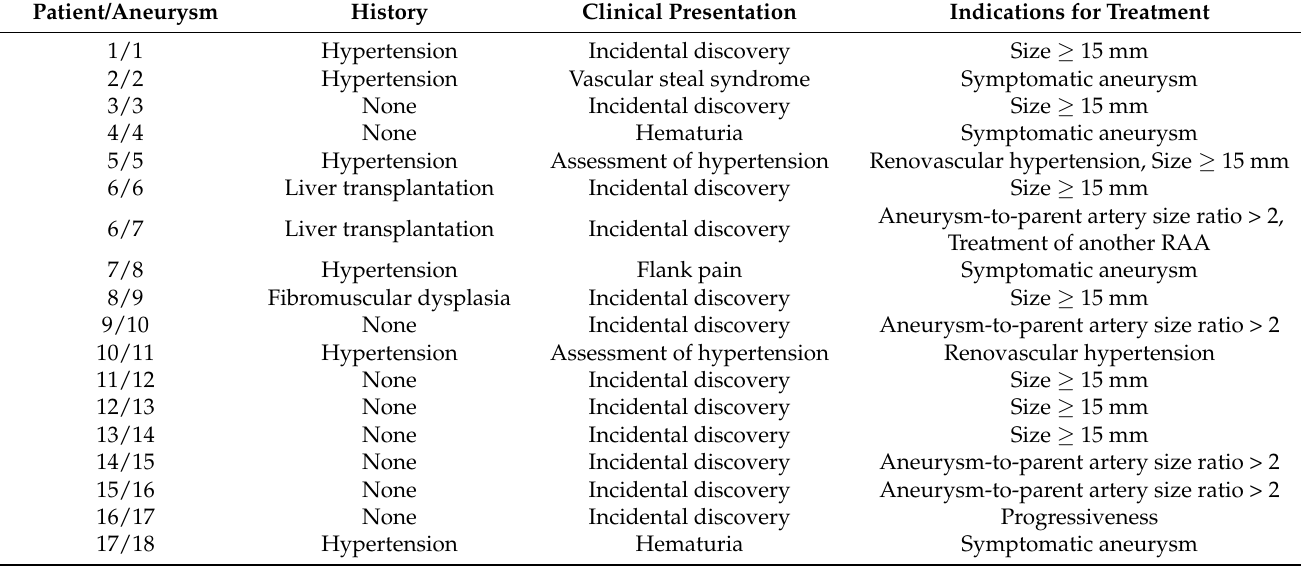
Table 2. History, clinical presentation, and indications for